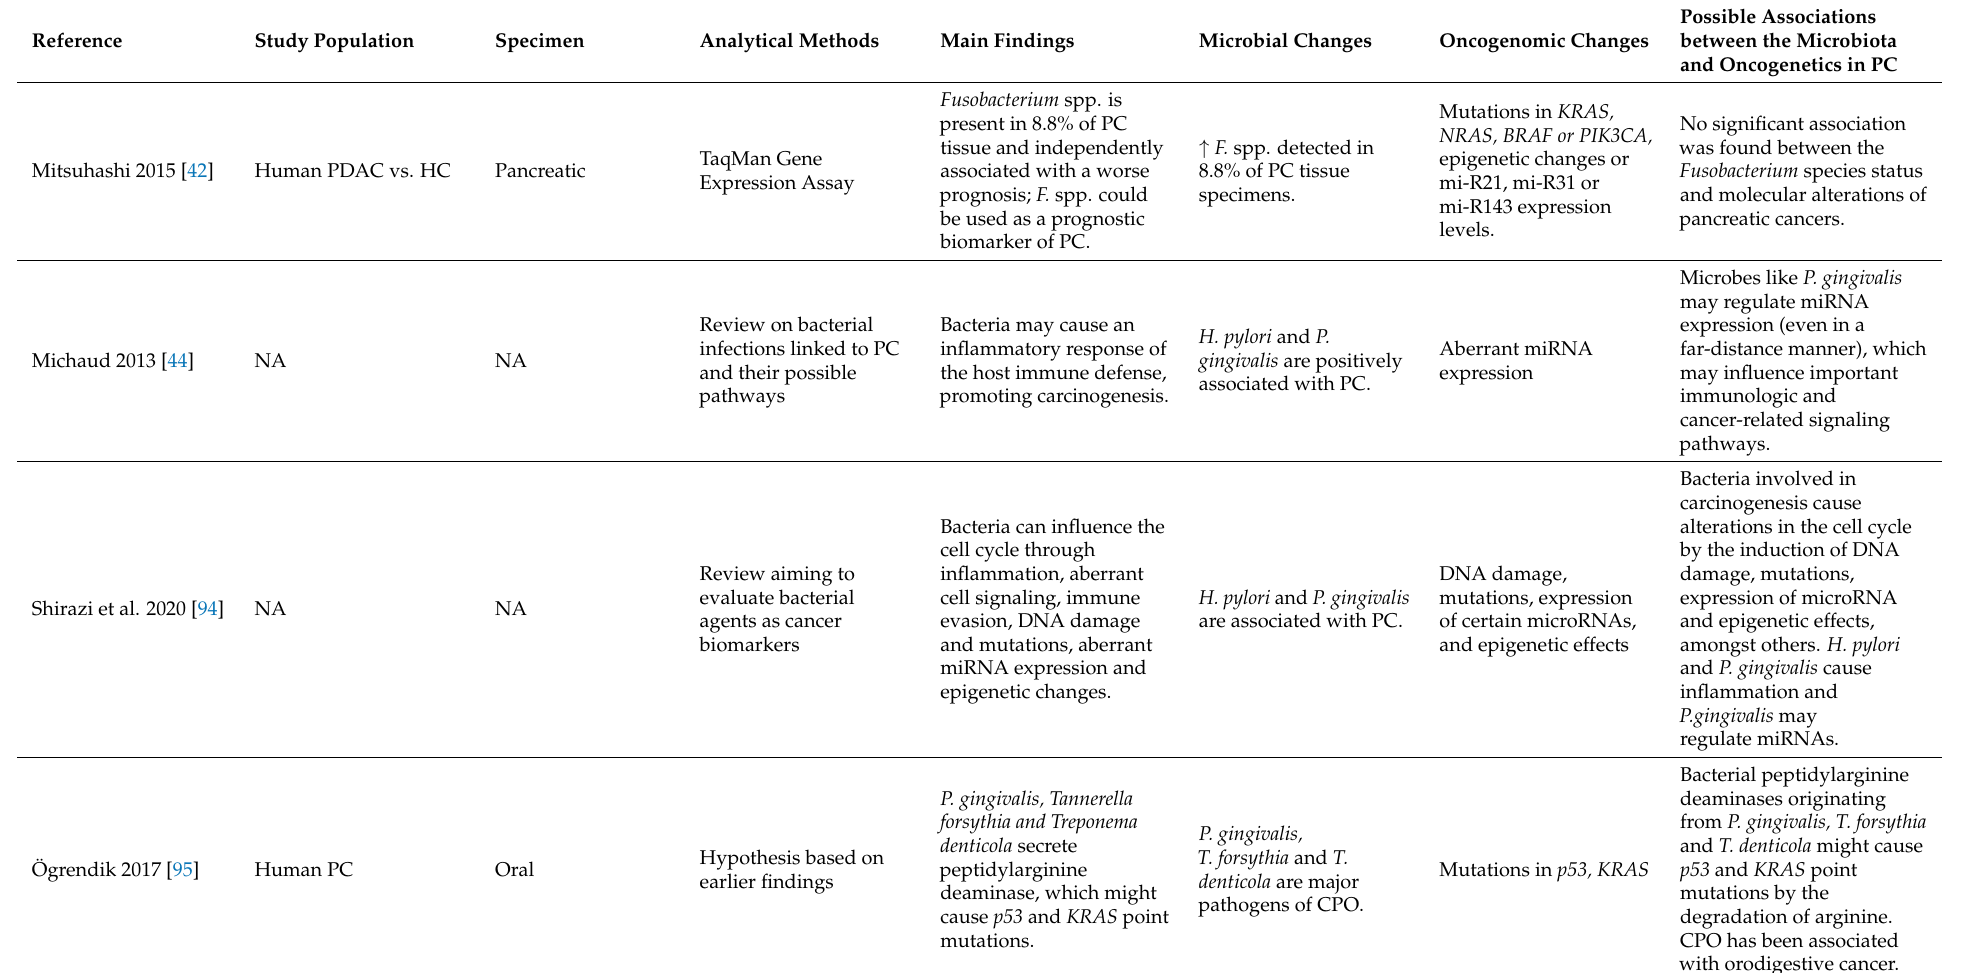
Table 1. Reviews and studies suggesting associations between microbial and oncogenomic changes in